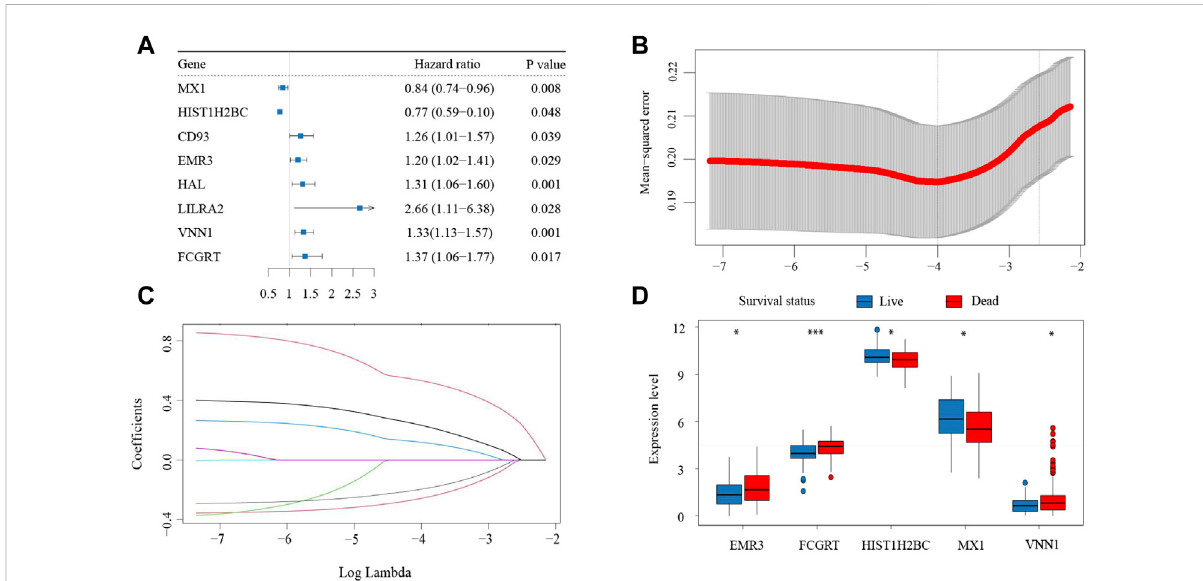
Establishment of the neutrophil-based prognostic model (A) Forest plot of eight neutrophil-related genes associated with survival. (B) Cross- validation for parameter selection (C) LASSO coef fi cient pro fi le plot against the log lambda sequence. (D) Expression of the fi ve prognostic genes in patients with different clinical outcomes. LASSO, least absolute shrinkage and selection